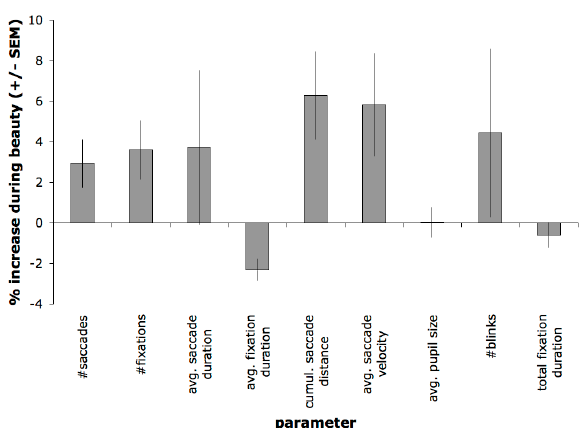
beauty compared to roughness judgments, expressed as a percentage of their average. Cumul. = cumulative, avg. =